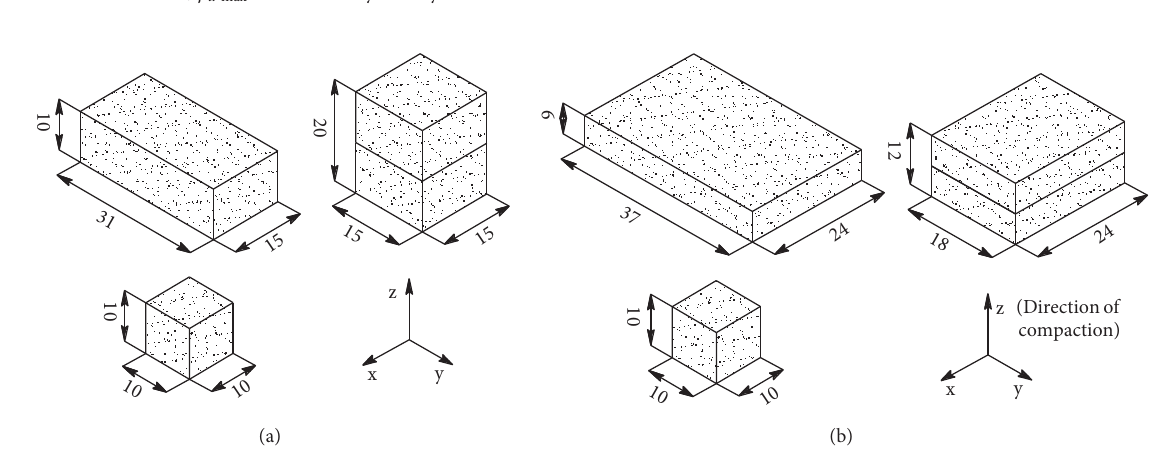
Figure 1: Preparation of samples. (a) Molded adobe. (b) Rammed adobe